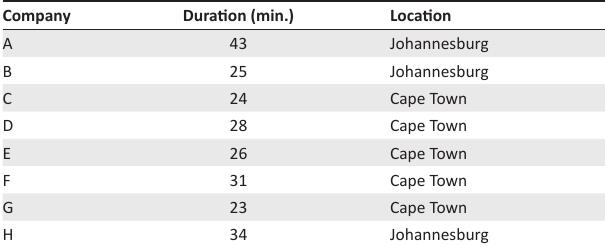
TABLE 1: Duration and location of